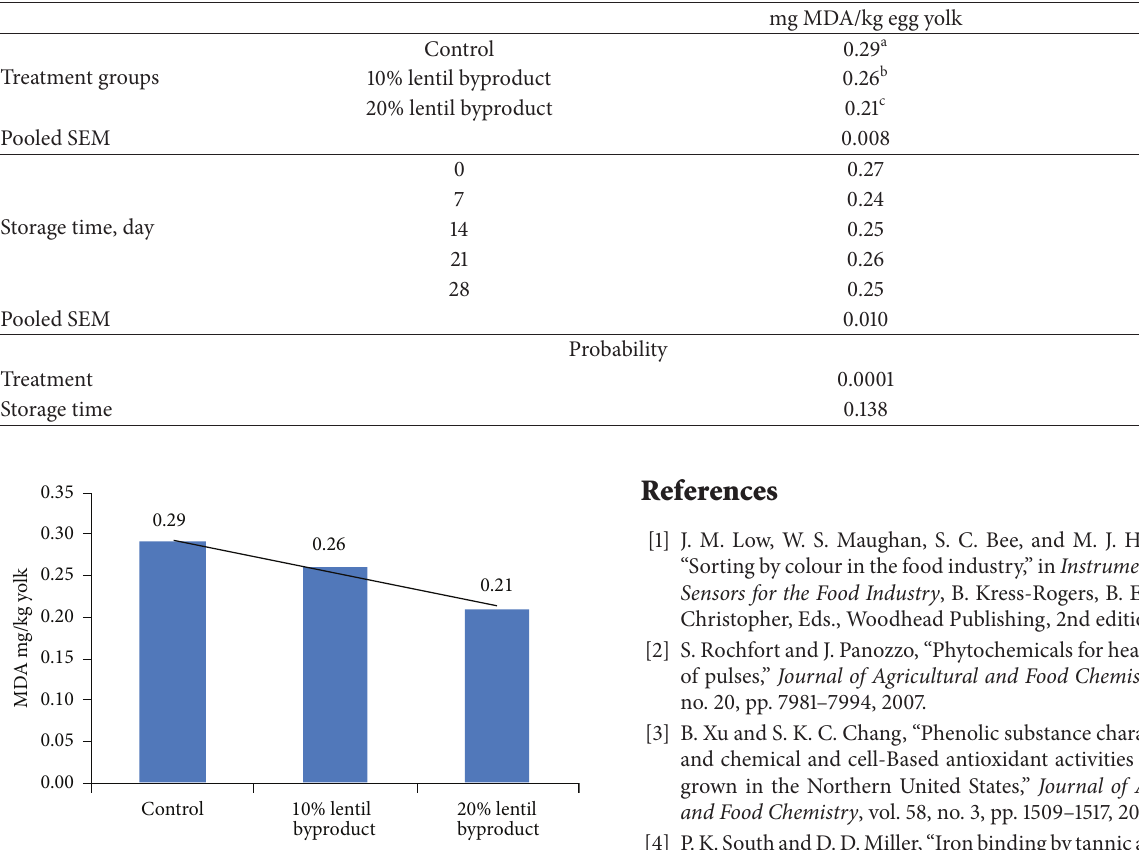
Figure 6: Effect of lentil byproduct on lipid oxidation.